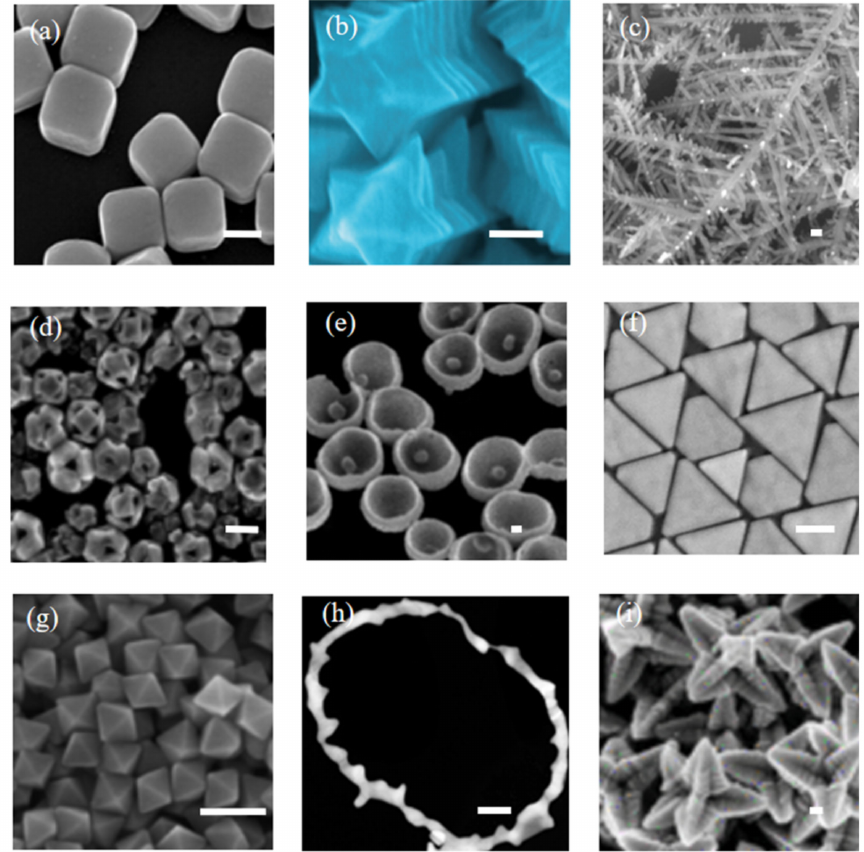
Figure 3. TEM/SEM images of ( a ) Ag/Au nanocubes [79], ( b ) GO/Au nanostars [73], ( c ) Ag nanodendrides [48], ( d ) Au nanocages [80], ( e ) Au nanobowls with Au seed inside [81], ( f ) gold nanotriangles [82], ( g ) Gold octahedrals [83], ( h ) Au nano ring [84], and ( i ) gold hollow stars [85]. Scale bar: 100